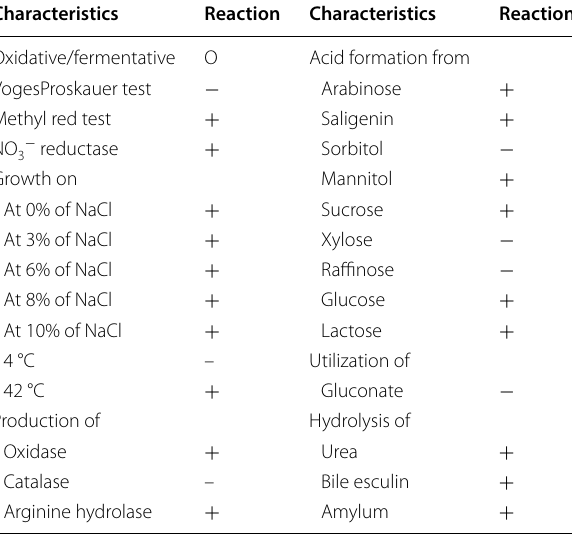
Table 1 Biochemical characteristics of the R8